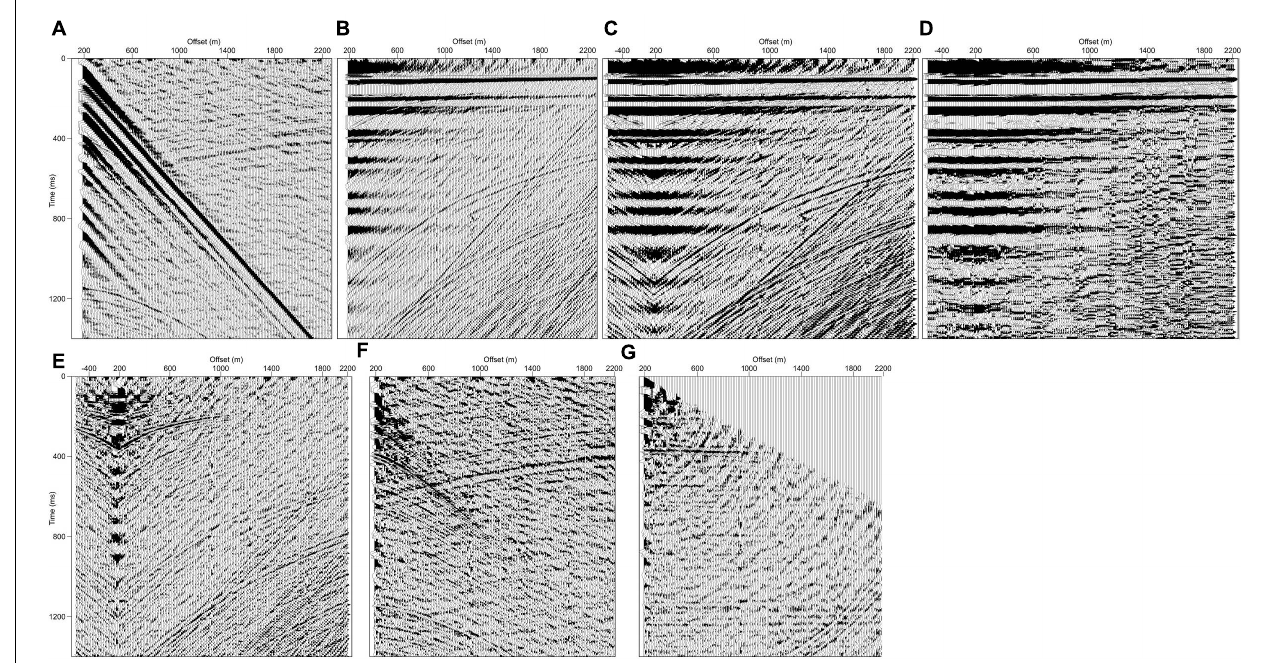
FIGURE 8 | (A) An illustrative field seismic record. Echo from the previous shot is very clear. Shallow reflections from the water layer are obscured by the very strong direct arrival; (B) field record after linear moveout; (C) doubling the short offsets and merging to build a shot gather that will mitigate the border effects of the median filter; (D) after applying the median filter with 11 traces; (E) same as (C) after subtraction of the median filter shown in (D) ; (F) field record [as shown in (A) ], after the full processing sequence of horizontal median filter with subtraction to attenuate the energy from the direct wave in the water; (G) processed record after NMO correction at 1,500 m/s (50% stretch mute allowed).